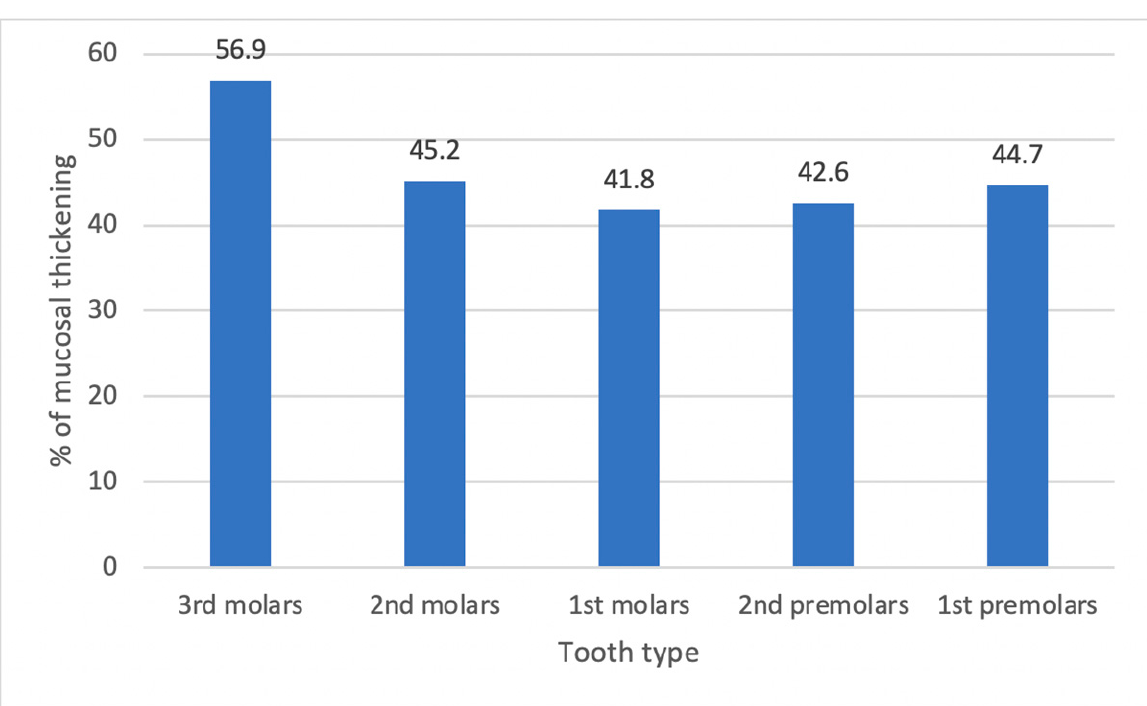
Figure 2. Different tooth types and their relation to sinus pathology.